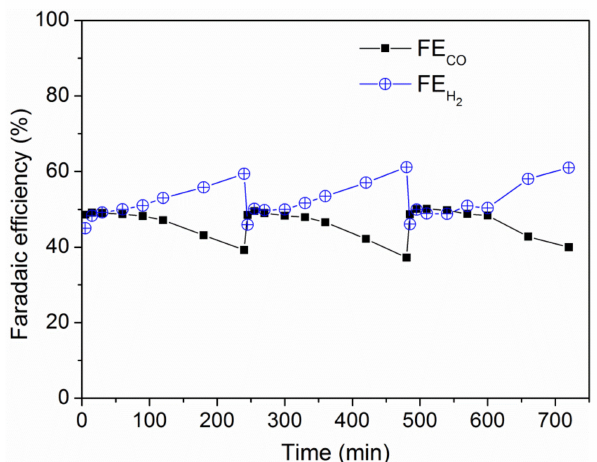
Figure 11. Cyclic yield curve of CO and H 2 on Ag foam electrode from re-saturated used electrolyte at − 2.67 V. Experimental conditions: anolyte, 0.5 M NaOH; catholyte, CO 2 -saturated 0.1 M KHCO 3 ; 25 ◦